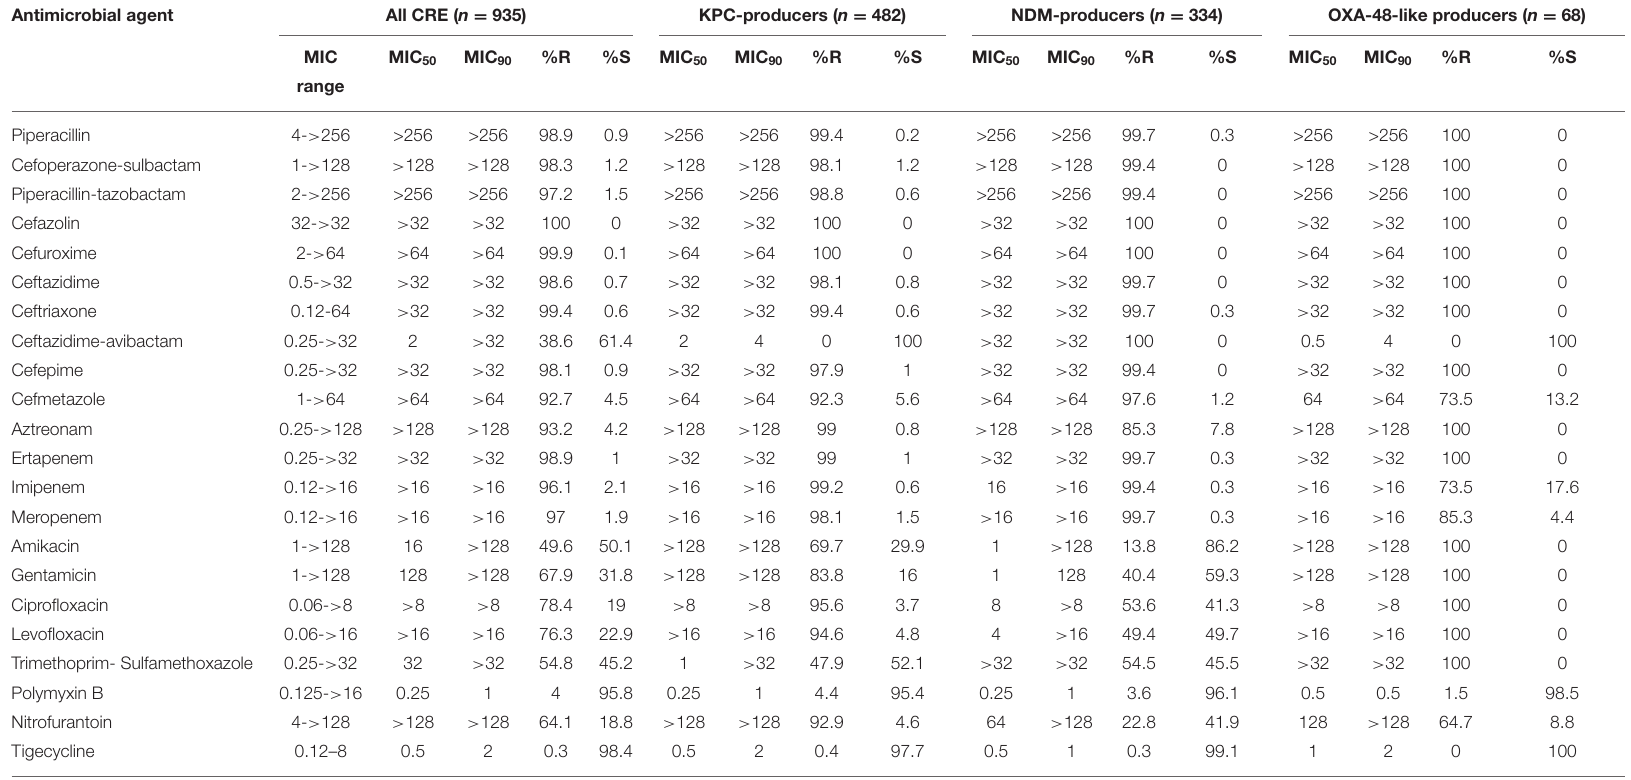
TABLE 1 | Antimicrobial susceptibility testing results of clinical CRE strains (MICs, mg/L). Antimicrobial agent All CRE ( n = 935)